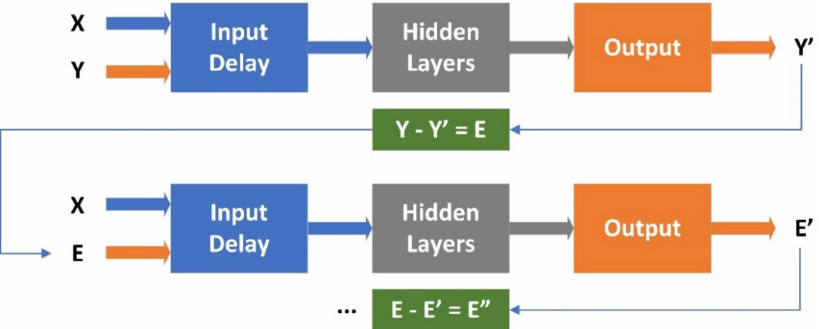
Figure 12. System configuration when evaluating the impact of error prediction (X—input data; Y—measured data; Y’—predicted output data; E—initial error; E’—leftover error predicted in the 1st iteration step; E”—leftover error predicted in the 2nd iteration step).